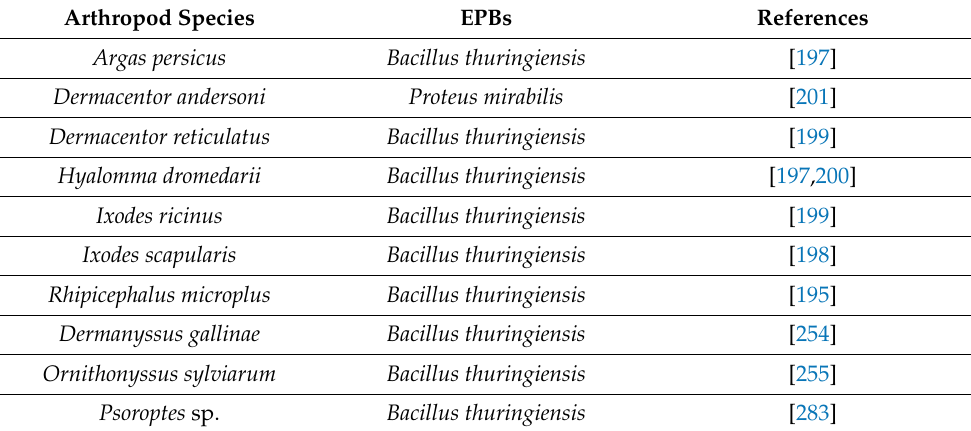
Table 3. Entomopathogenic bacteria (EPBs) active against different arthropod